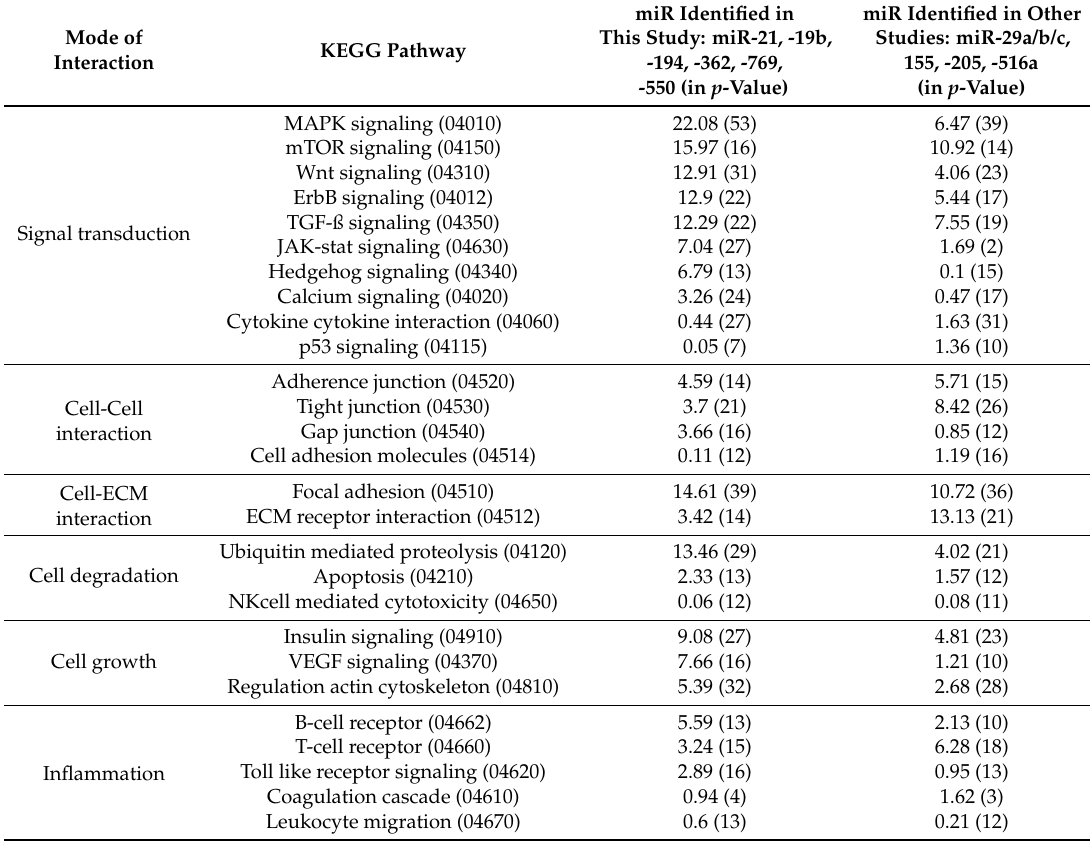
Table 1. miRNA associated pathways in Aneurysm Disease: KEGG Pathways with predicted interaction enrichments for miR-362, -19b-1, -194, -769, -21, -550 (results from this study) and for miR-29a/b/c, -155, -205, -516a (previously published results). Ln( p -value) is a natural logarithmic scale of the p -value obtained from a χ -square test comparing expected number of genes with interaction and the actual number composing the pathways (DIANA algorithm). The higher value thus indicates a larger number of genes within the pathway predicted to be regulated by at least one of the respective miRs. Values ranged from 17.64 to 0.01 (3rd column) and 13.13 to 0.04 (4th column). The numbers in brackets indicate the number of gene interactions within the pathway respectively. Note that mTOR- and TGFß-signaling, adherence junction and focal adhesion and ubiquitin-mediated proteolysis receive concordantly high scores in both